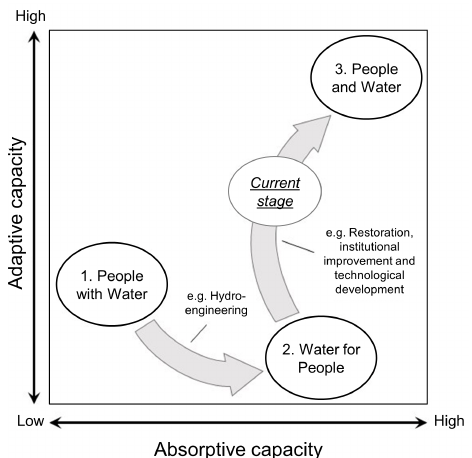
Figure 5. Global development of socio-hydrological resilience on the “resilience canvas”. Three main developmental stages are (1) People with Water, (2) Water for People, and (3) People and Water. The current global socio-hydrological system has been mov- ing from the second to the third